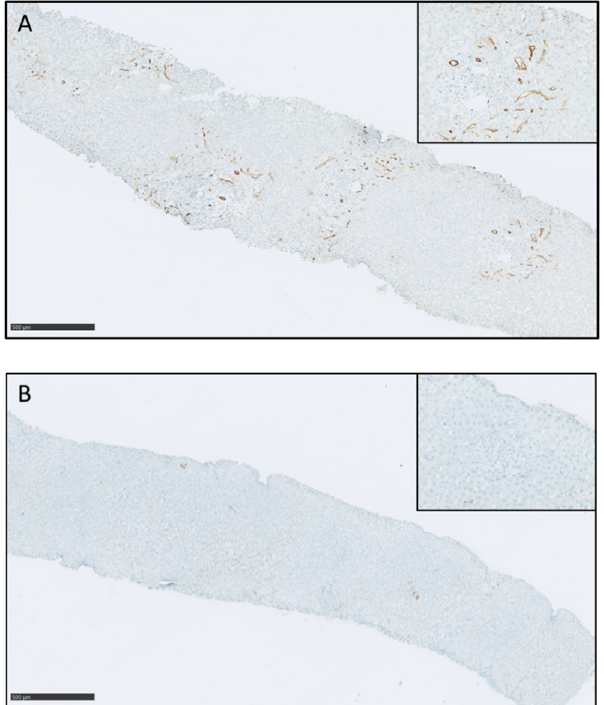
Figure 3. Immunostaining for C4d. Positivity of C4d staining in the vessels of the portal tracts (( A ), magnification 5×); in the inset is shown the strong positivity of the staining in portal vessels and capillaries (arrow, magnification 20×). In ( B ), the staining is negative in all the biopsy (magnification 5×); in the inset, a completely negative portal tract (magnification 20×).